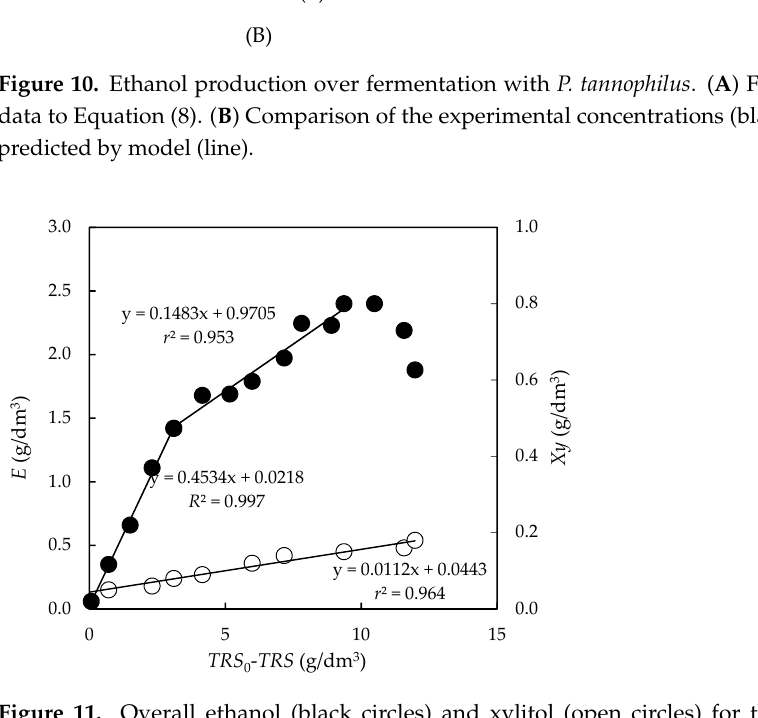
Figure 11. Overall ethanol (black circles) and xylitol (open circles) for the fermentation with P. tannophilus .